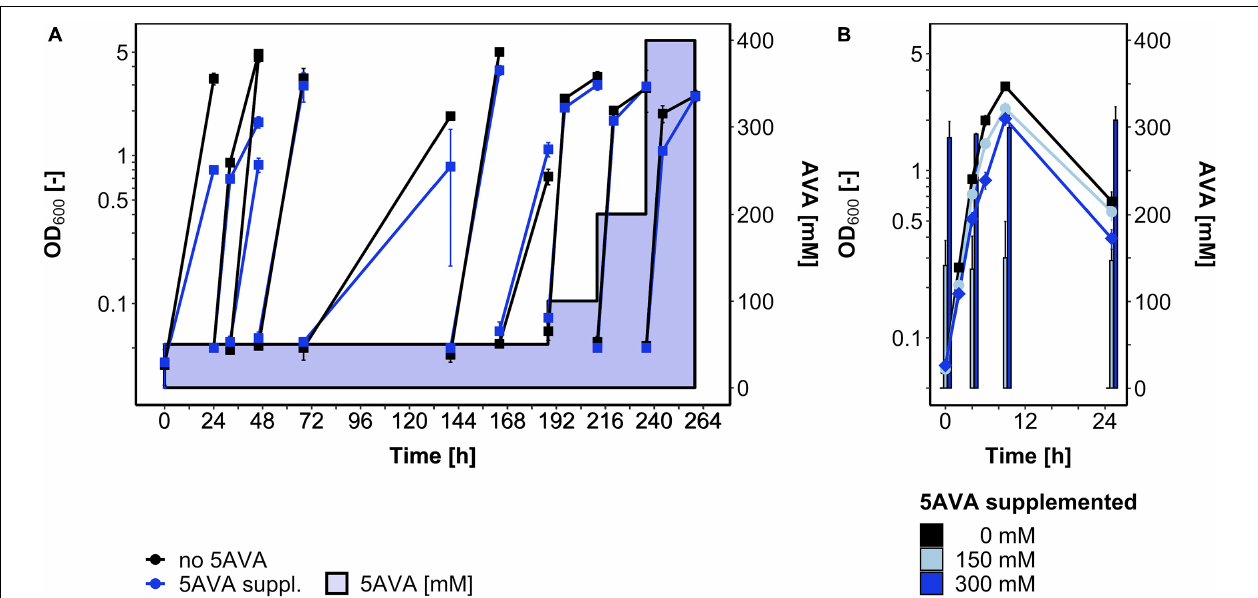
FIGURE 4 | ALE for enhanced 5AVA tolerance (A) and growth of strain AVA10 with different 5AVA concentrations (B) . B. methanolicus cells were cultivated in MVcMY medium supplemented with various concentrations of 5AVA. (A) OD 600 values during the ALE experiment with B. methanolicus WT are plotted for growth without (black squares) or with 5AVA (blue squares; 5AVA concentrations ranging from 50 to 400 mM indicated as blue-shaded area). Passage intervals varied (8–72 h), and every second passage was harvested and stored at -80 ◦ C after plating and isolation of a single colony. (B) ALE strain AVA10 was cultivated in MVcMY medium supplemented with 0 mM (black squares), 150 mM (light blue circles), and 300 mM (blue diamonds) 5AVA. The 5AVA concentration in the supernatant was determined by HPLC. Values and error bars represent means and standard deviations of triplicate